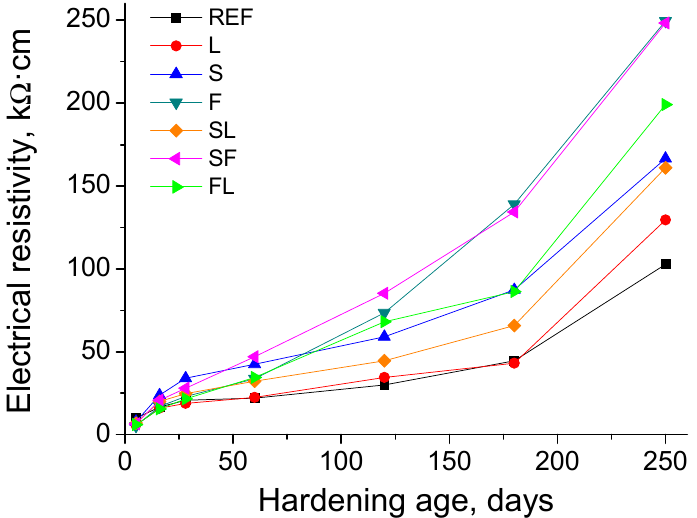
Figure 3. Electrical resistivity results for the different types of mortars tested.